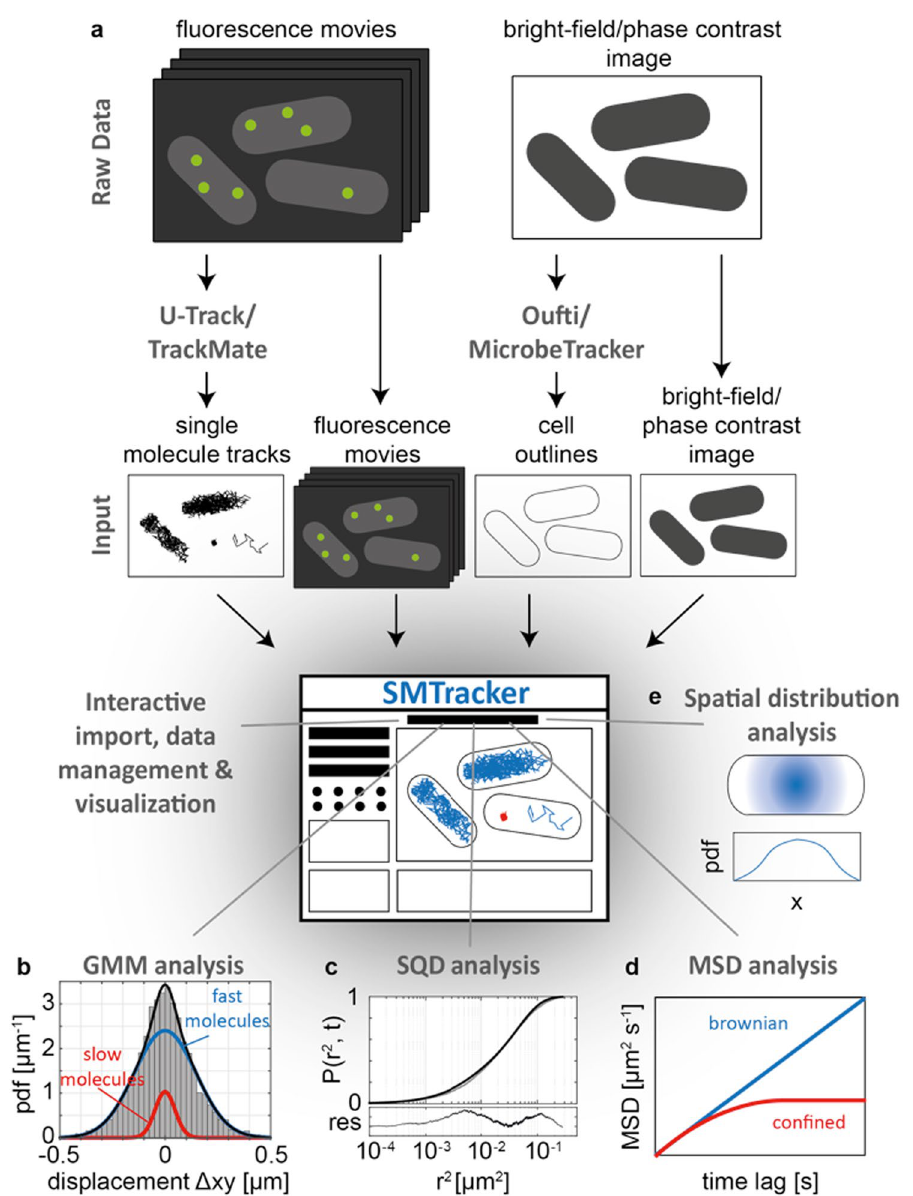
Figure 1. The SMTracker software suite. ( a ) After importing raw data of tracks and cell outlines, the import panel allows the user to interactively explore the data, identify characteristic patterns and potential experimental artifacts. ( b ) The Gaussian mixture model (GMM) analysis runs a fit on the probability density function (pdf) of positional 1D displacements, assuming a two- (or three-) state model with a mobile (blue line) and immobile (red line) subpopulation of molecules, thereby extracting the diffusion coefficient and fraction size of each subpopulation. ( c ) Squared displacement (SQD) analysis considers the cumulative probability function of squared displacements and provides an alternative way to analyze up to 3 different subpopulations in the biological sample. ( d ) The mean-squared displacement (MSD) analysis plots the time-ensemble averaged MSD vs. the time-lag, revealing the type of motion exhibited by the molecules. A linear dependency of the MSD on the time-lag indicates Brownian diffusion (blue line), whereas an asymptotic curve is indicative of confined (or sub-diffusive) motion. ( e ) In the spatial distribution analysis (SDA) panel the software generates 2D- and 3D- heat maps and distributions of trajectories along the x- and y- axis of the cell, allowing the identification of specific localization patterns of molecules, e.g., cytoplasmic, membrane- or